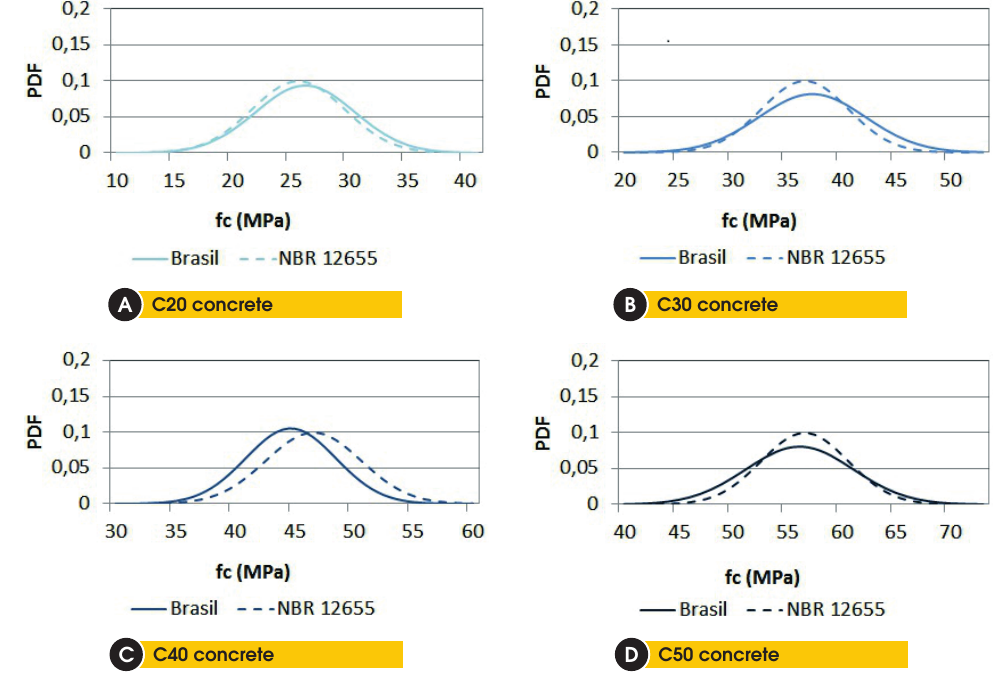
Comparison between the distribution function of concrete produced in Brazil and the ones foreseen in NBR